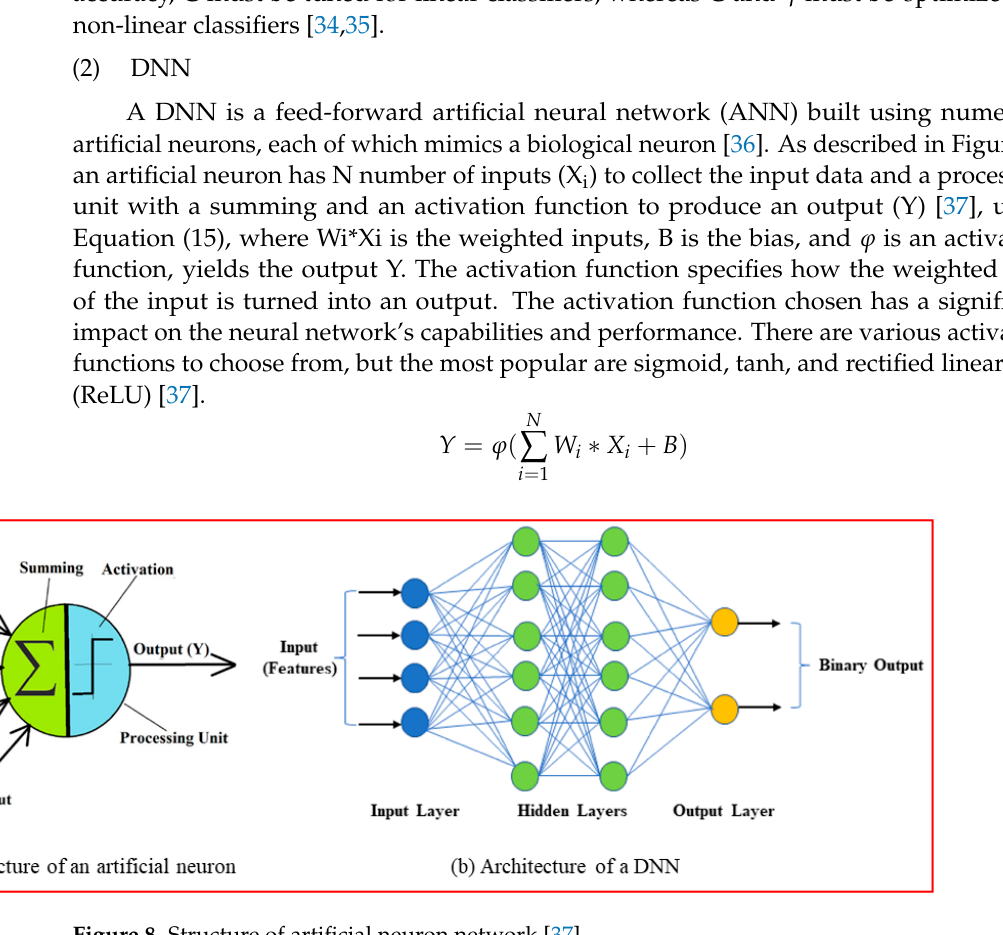
Table 2. Configuration of the DNN model.